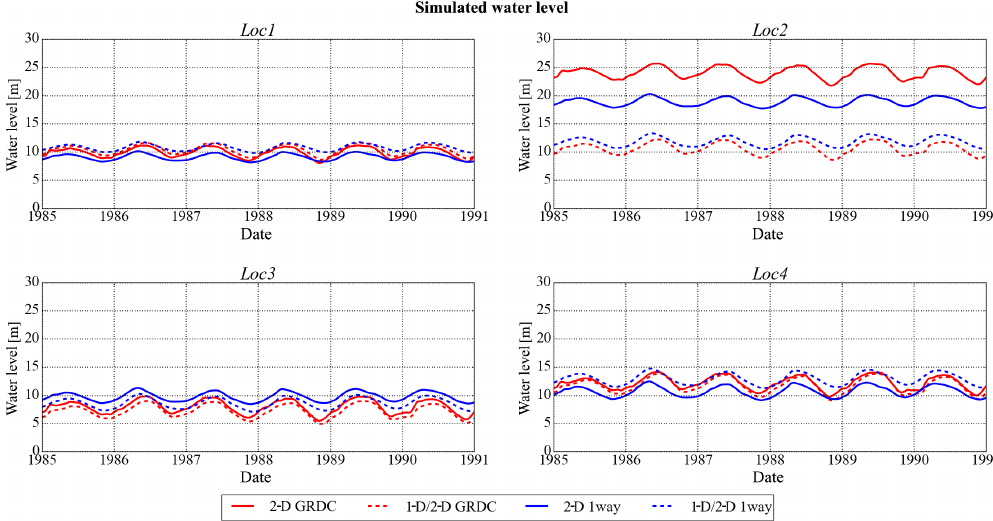
Figure 7. Plot of simulated water levels at four different observation locations throughout the study domain.